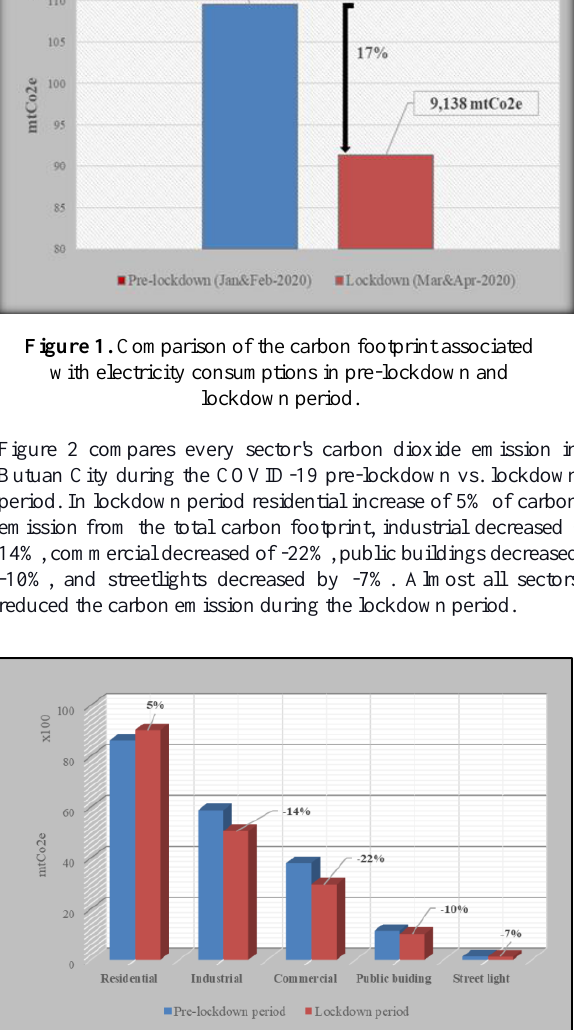
Figure 2. Comparison between the Butuan City carbon footprint trends associated in every sector of electricity consumption in pre-lockdown vs. lockdown periods.